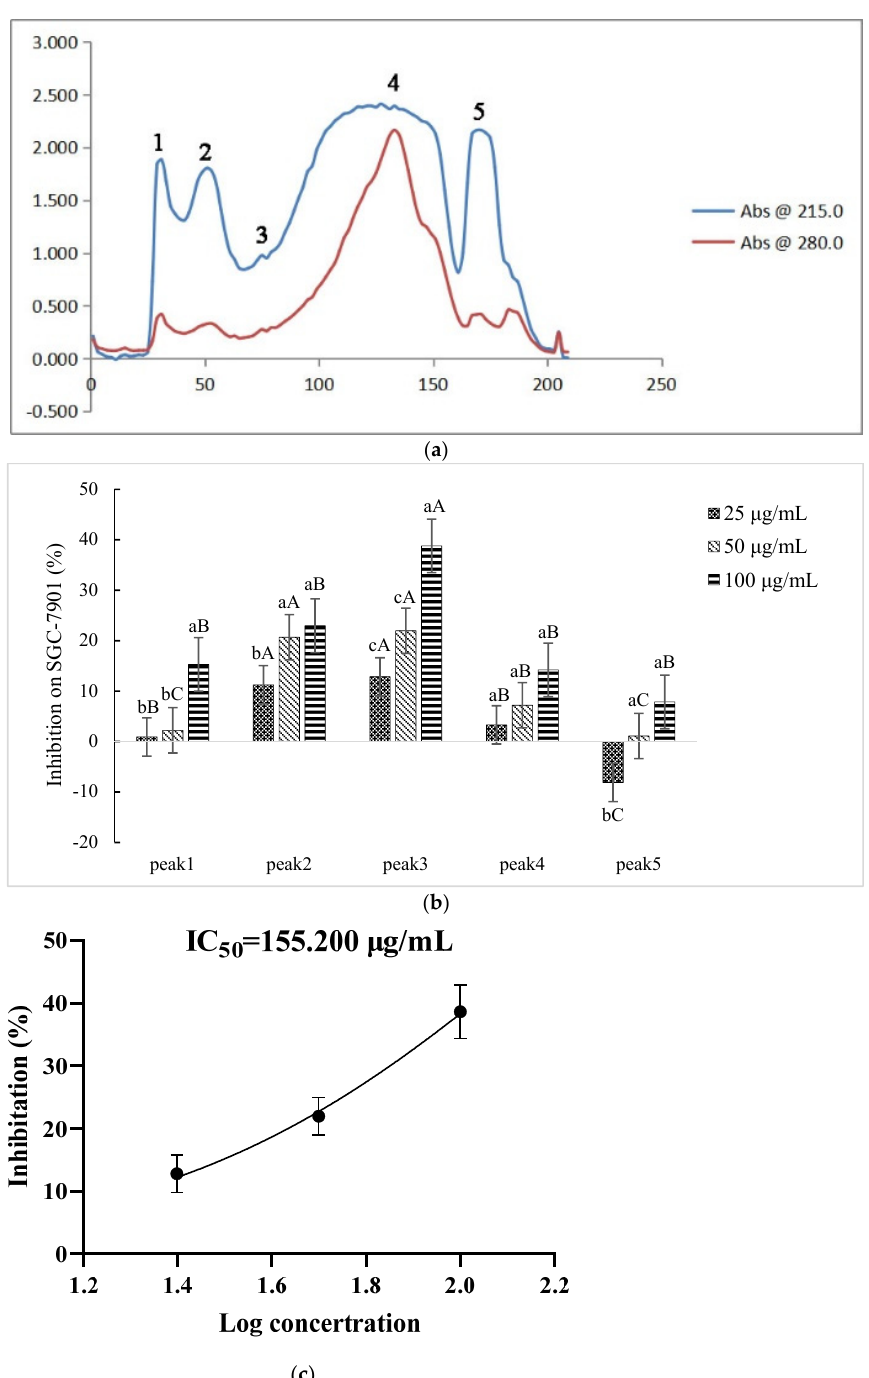
(Figure 3a): peaks 1–4 were denoted as Sects. II-3-1-4, respectively. Each fraction (differ- ential peak collection) was treated the same as above. Except for Sect. II-3-4 (peak 4) at a lower concentration (10 μ g/mL), the fractions expressed inhibitory effects (Figure 3b). It was found that Sect. II-3-3. (peak 3) was more effective than the other fractions at any concentration, and its IC 50 value for SGC-7901 cells was 70.900 μ g/mL (Figure 3c). There- fore, Sect. II-3-3 was collected for further separation or purification. ( a )